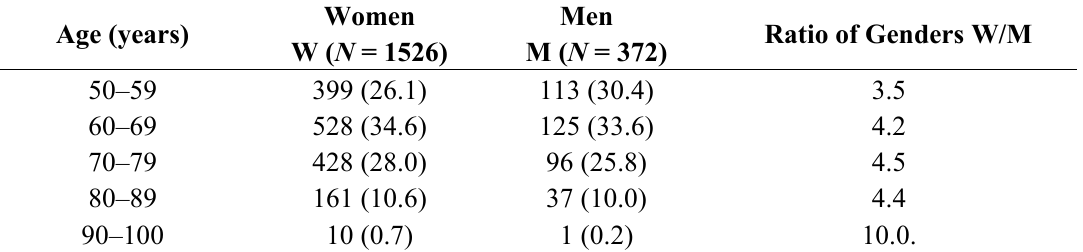
Table 3. Distribution of 1898 patients into five age decades (range 50–100